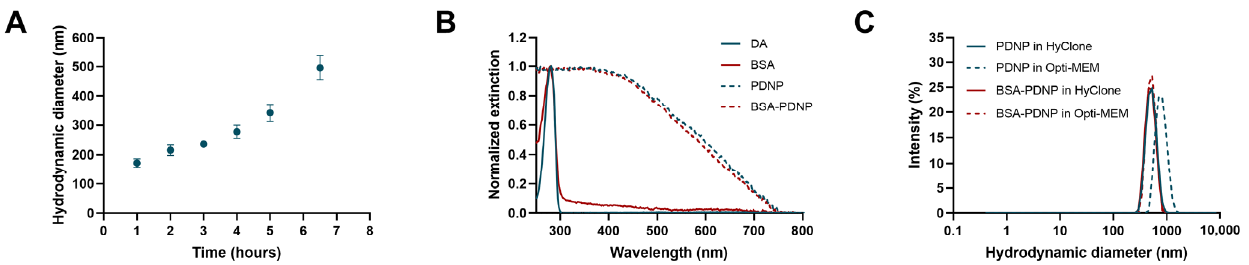
Figure 1. Characterization of BSA-coated and uncoated polydopamine nanoparticles (PDNPs). ( A ) Evolution of the PDNP hydrodynamic diameter in the function of reaction time as measured by DLS. All samples were sonicated by tip sonication to remove potential agglomerates. ( B ) Normalized UV/Vis spectrum of DA (blue), BSA (red), 500 nm PDNPs (dashed blue) and 500 nm BSA-coated PDNPs (dashed red). ( C ) Size distributions representing the stability of uncoated 500 nm PDNPs in water (blue) and Opti-MEM (dashed blue), showing a clear size increase after incubation in Opti-MEM. BSA-coated PDNPs maintain the same size distribution in both waters (red) and Opti-MEM (dashed red). Measured by DLS for an incubation time of 15 min.